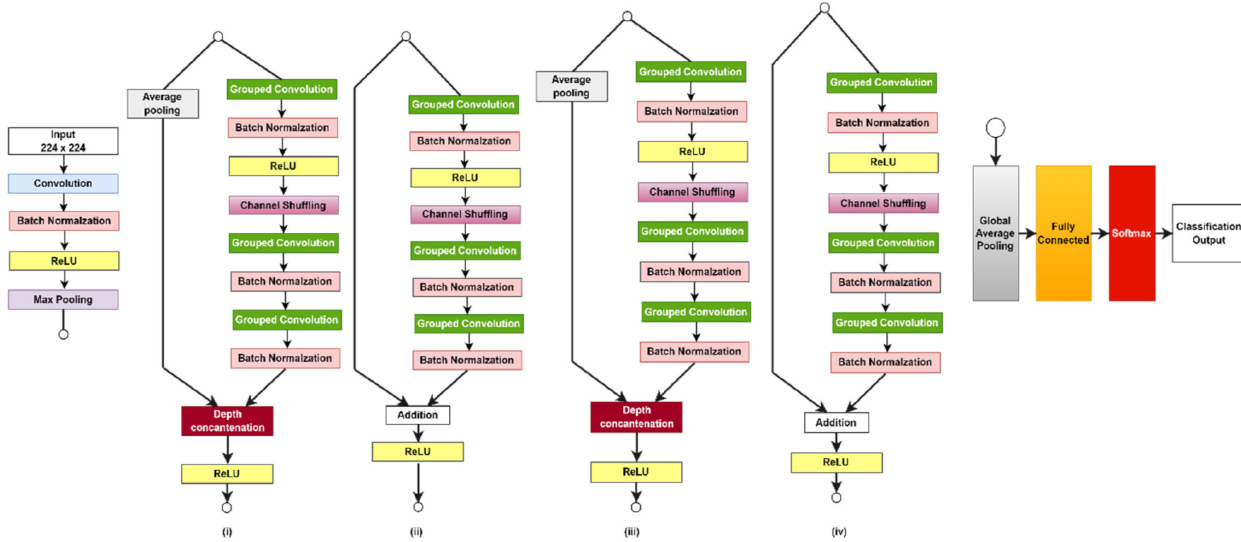
Figure 5. The proposed deepShuffleNet architecture consists of several building